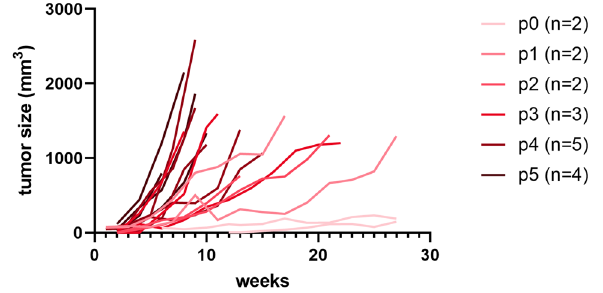
Figure 1. Growth of the model. Growth curves of RT-AS5 tumors in SCID mice in passage 0 to 5. Each line represents a separate tumor. The number of mice per passage varies according to the availability of tumor tissue.